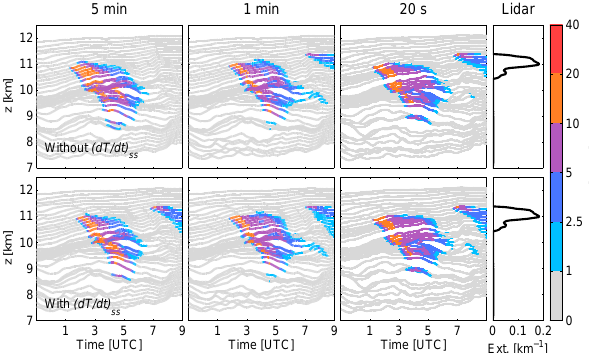
Figure 6. Vertical position of the trajectories displayed as a function of the time prior to their arrival at Jungfraujoch at 09:00UTC (right edge of each panel). Colour coding: ZOMM simulations of the ice water content q i in ppmv. First column: offline trajectories with a temporal resolution of 5min. Second column: offline trajectories with a temporal resolution of 1min. Third column: online trajecto- ries (20s temporal resolution). Upper row: simulations along trajec- tories based directly on COSMO-2 model output. Lower row: sim- ulations with small-scale temperature fluctuations superimposed on the original temperature time series. All simulations: assuming nu- cleation to be only homogeneous, and with initial humidity reduced by 5% with respect to the COSMO-2 model value.